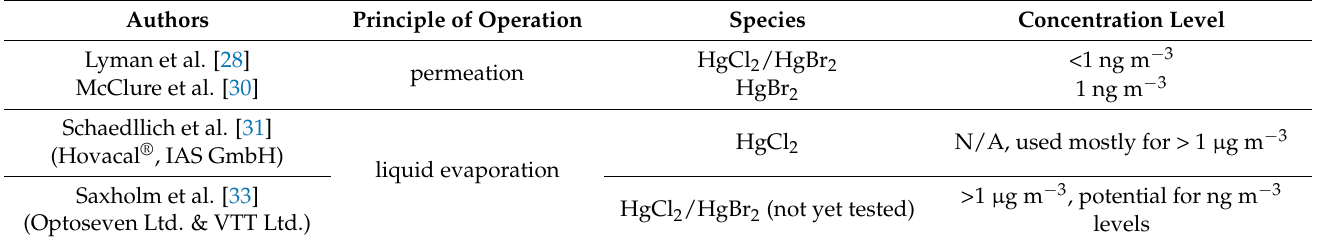
Table 1. Comparison of GOM calibration